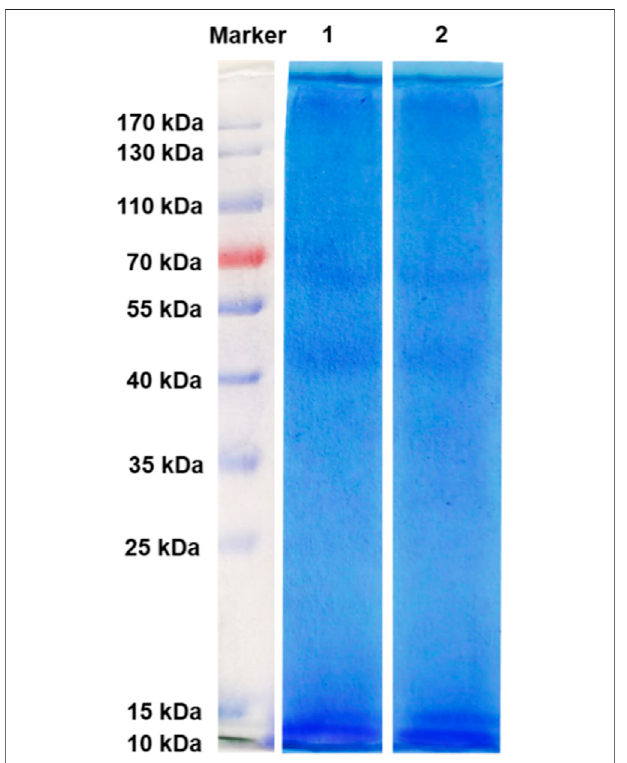
FIGURE 10 | SDS-PAGE pattern, lane 1: K-C, lane 2: